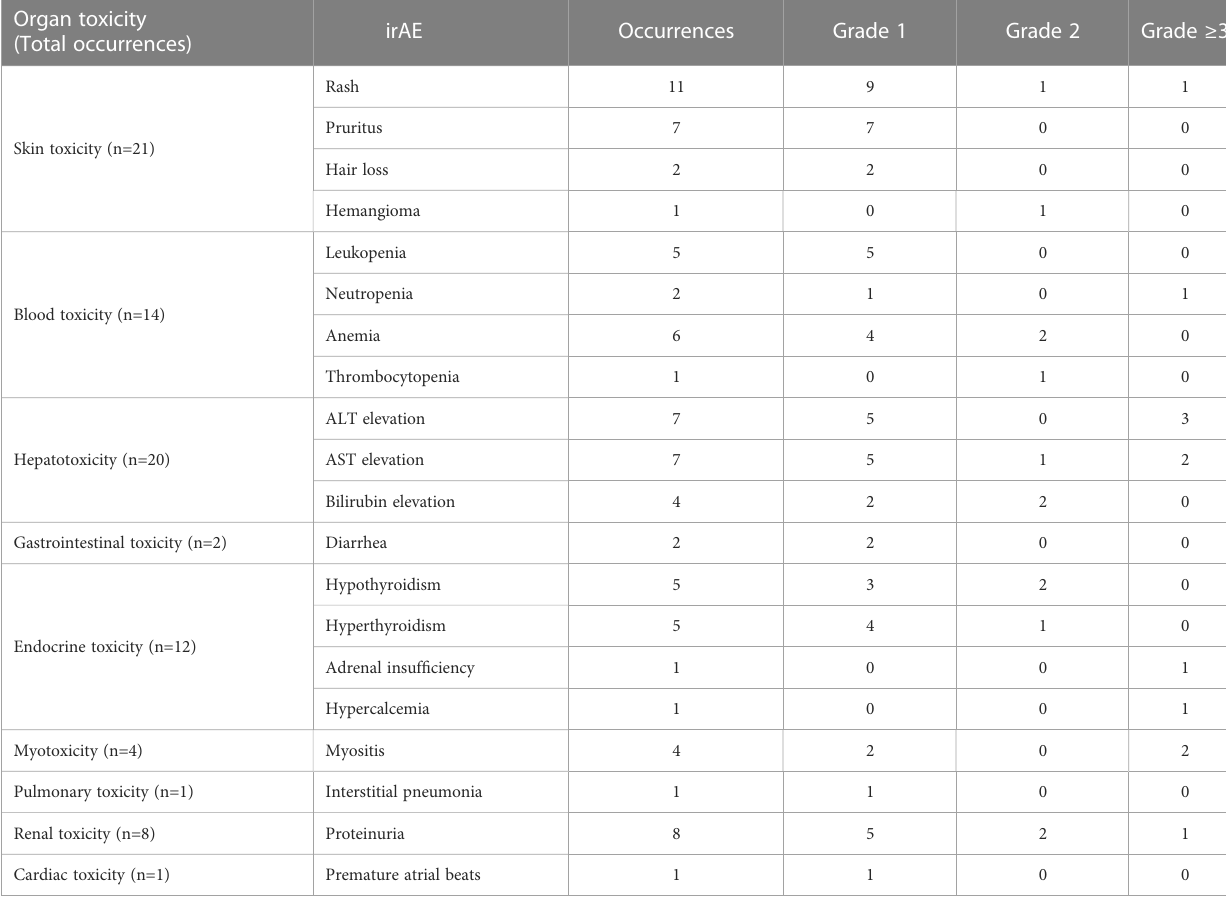
TABLE 2 Patient irAE